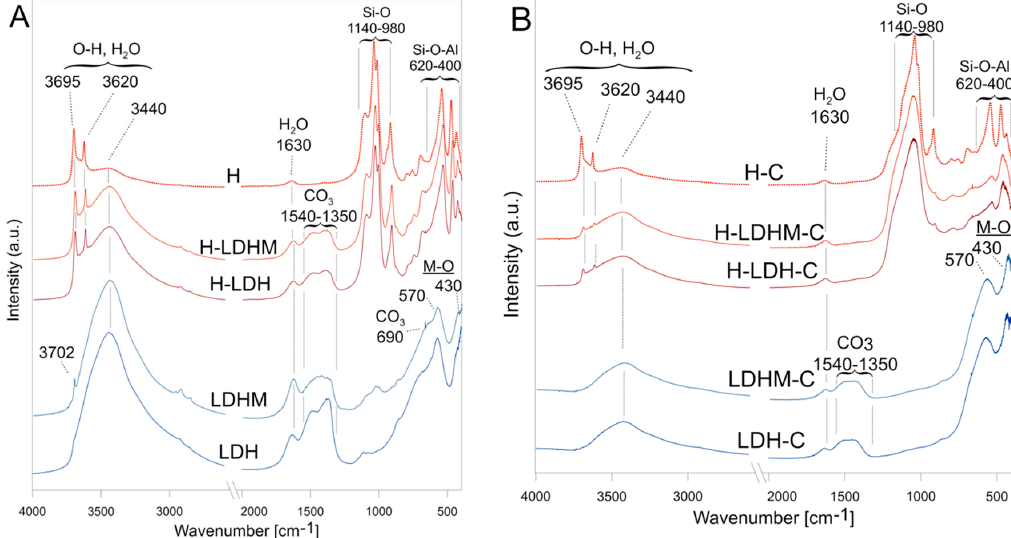
Figure 2. Fourier transformed infrared (FTIR) spectra of ( A ) uncalcined and ( B ) calcined materials.